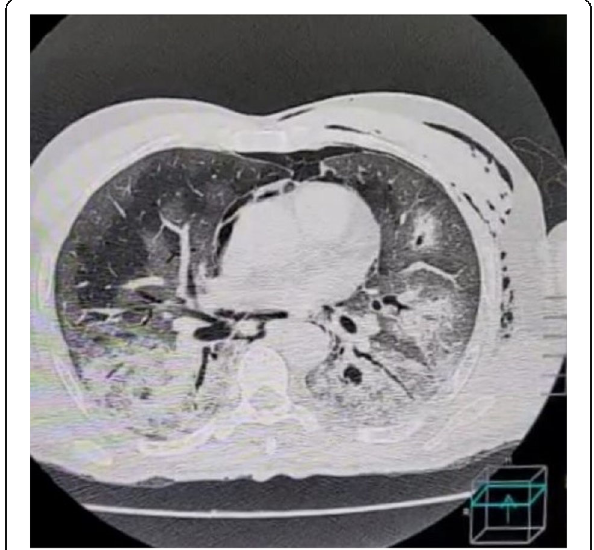
Fig. 1 (abstract P0424). See text for description